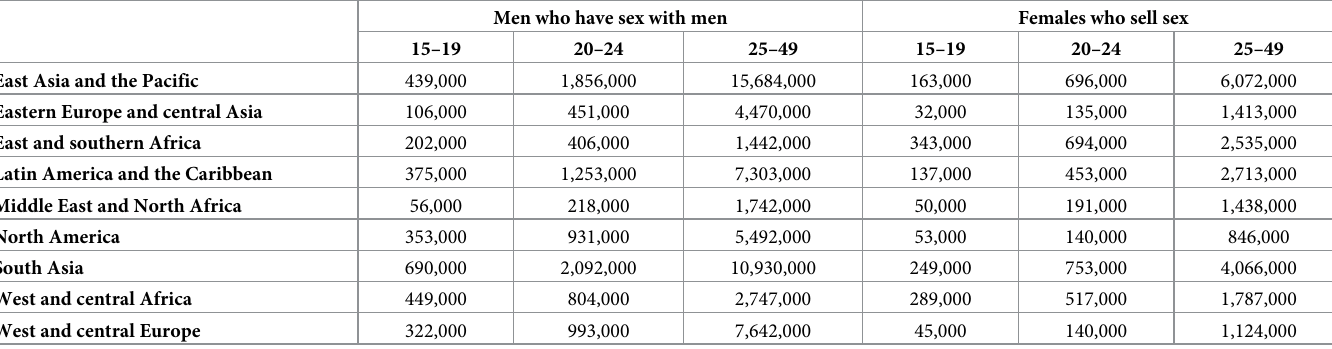
Table 1. Population sizes of men who have sex with men and females who sell sex, by age and UNICEF region. Men who have sex with